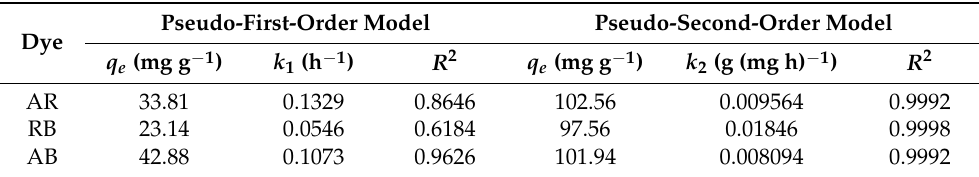
Figure 5. Dye removal rates ( a ) and adsorption kinetics ( b ) of pMIL-88A/PAN NFM. The average fits under pseudo − first ( c ) and pseudo − second − order ( d ) kinetic models for the adsorption of AR, RB, and AB using pMIL-88A/PAN NFM. Table 1. Calculated results of pseudo-first- and pseudo-second-order constants for the adsorption of AR, RB, and AB using pMIL-88A/PAN NFM.